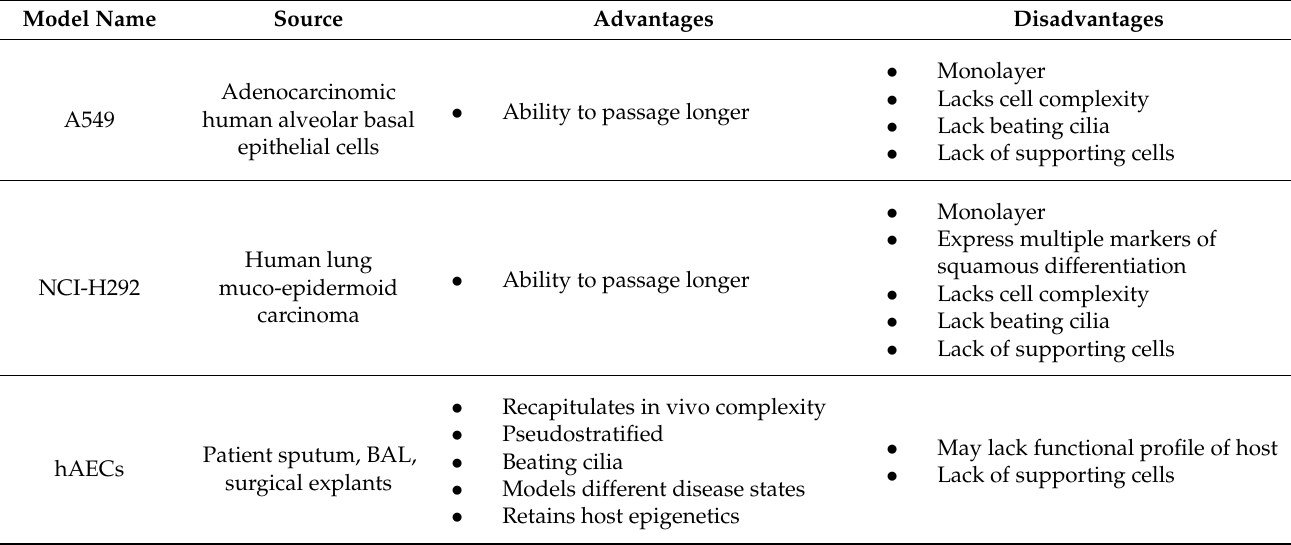
Table 1. Selected human respiratory epithelial cell in vitro cell